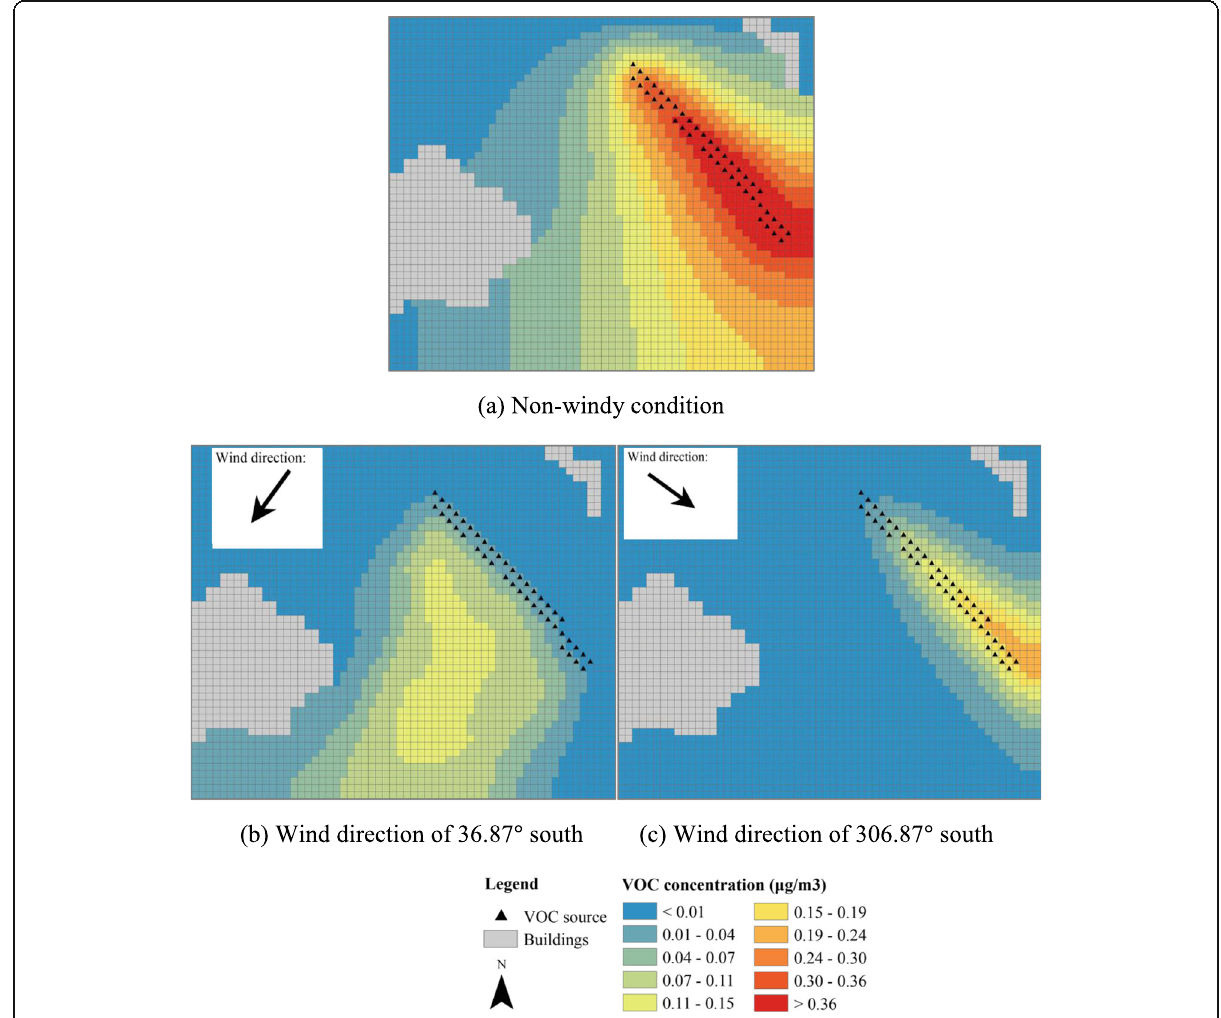
Fig. 8 VOC concentrations of the base